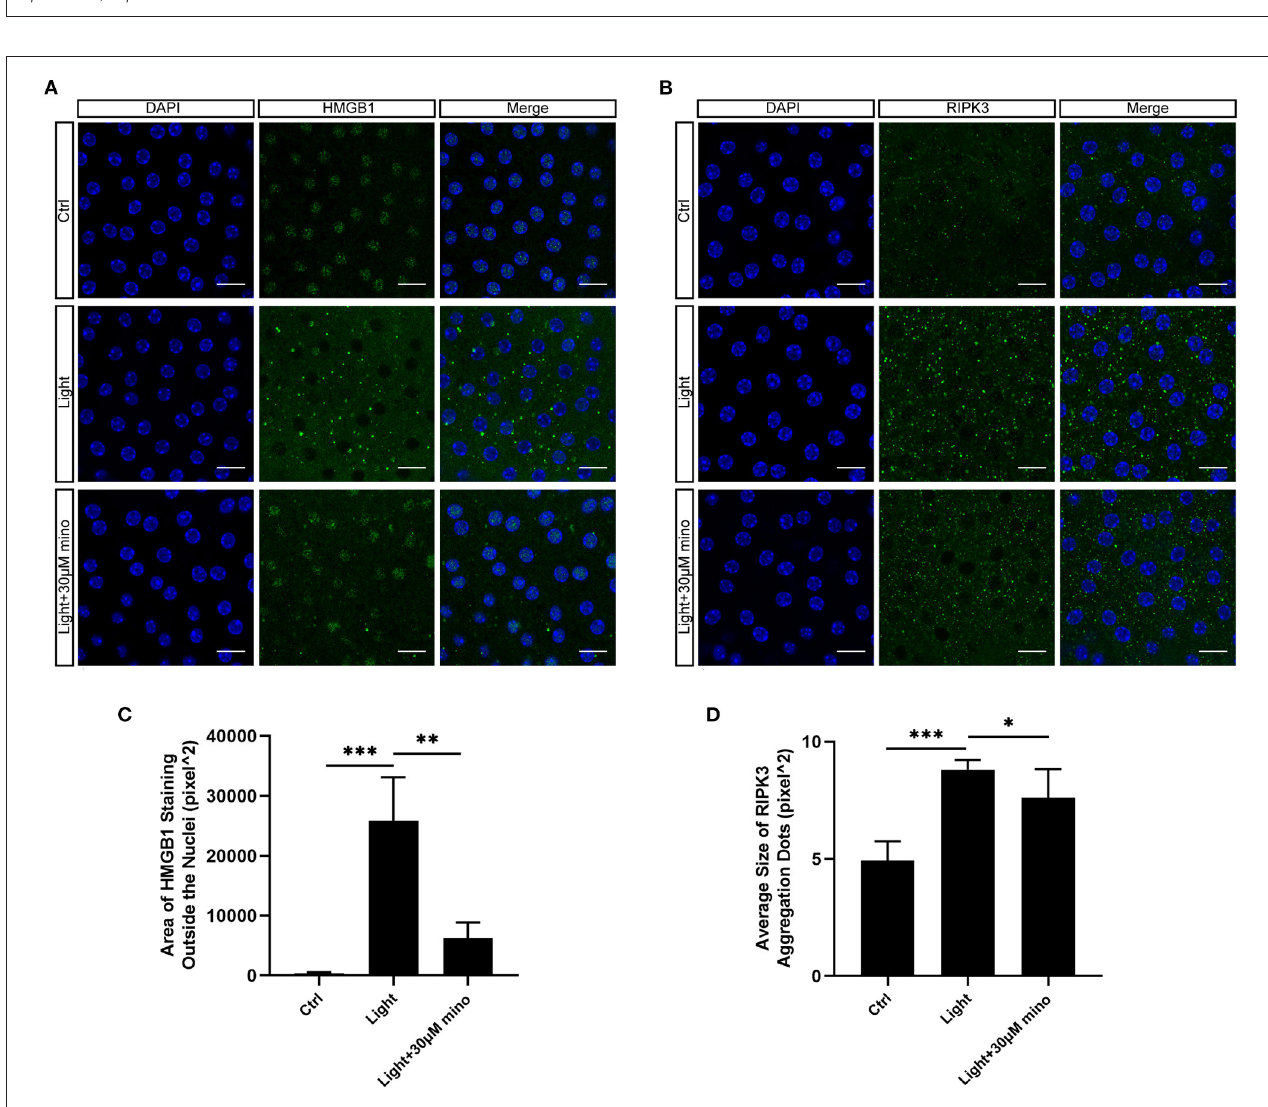
FIGURE 6 | exposure time was 1h. Scale bar: 50 µ m. (D) Superposition of three groups ROS diagrams in (B) . Curve of blue light group became sharp and moved right. Curve of blue light with minocycline group moved right. (E) Quantitative analysis of (B) . ROS in both blue light group and blue light with minocycline group was increased ( n = 3). (F) Quantitative analysis of (C) . In blue light group, decrease in fluorescence intensity ratio suggested decrease in 1 ψ m ( n = 10). ** p < 0.01, *** p < 0.001.